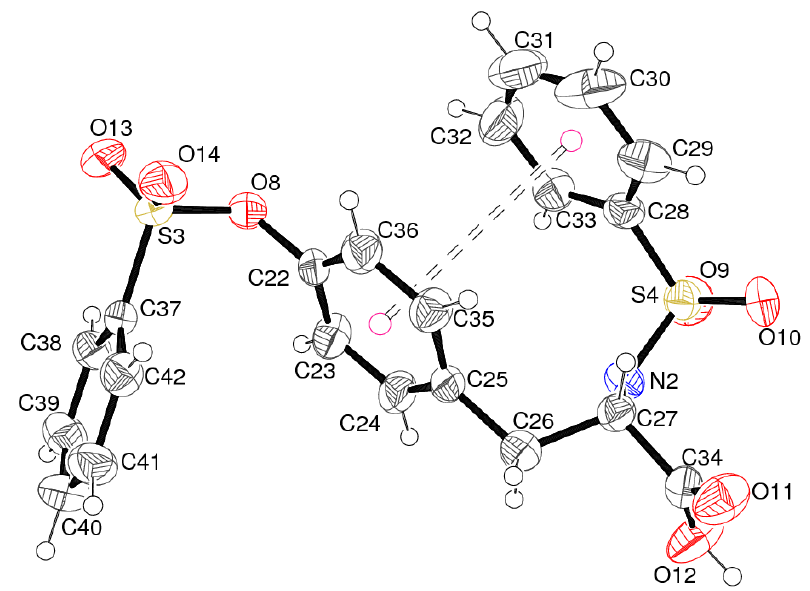
Figure 3. The molecular structure of molecule 1B showing 50% displacement ellipsoids. The intramolecular  –  stacking interaction is indicated by a double-dashed line.